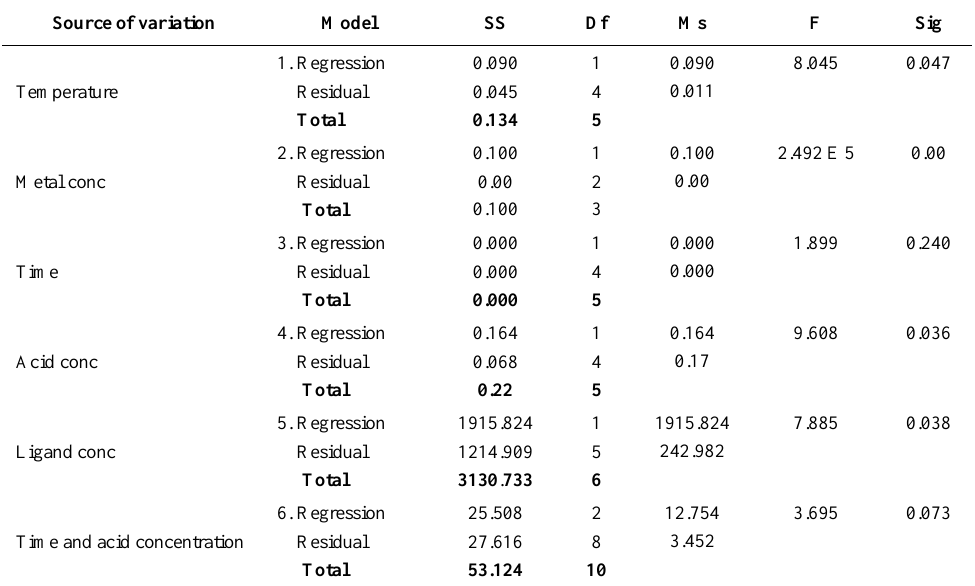
Table 6. Results of ANOVA Test for preparation and extraction of Fe(1I1) H 2 SAL Complex